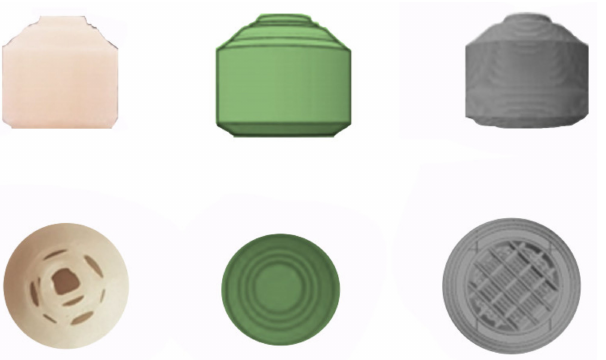
Figure 5. 3D-printed pregabalin gastrofloating tablets. The internal structure of tablet is composed of a grid infill with void space filled with air so that the tablet has low density, which helps the buoyancy of the tablet in media